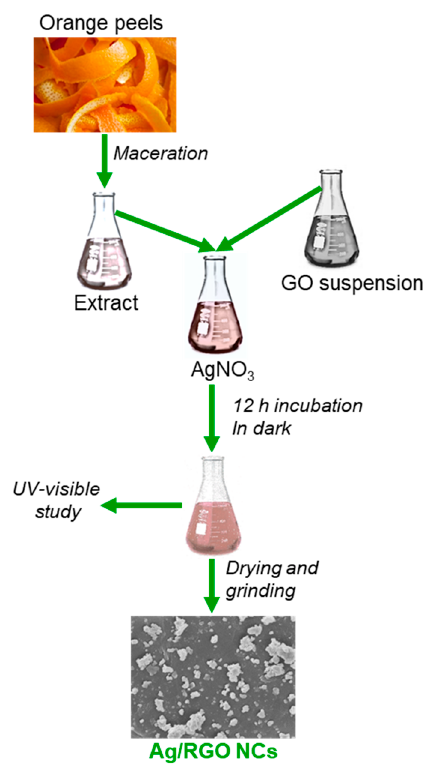
Figure 1. A schematic of green synthesis of Ag/RGO NCs using orange peel extract.